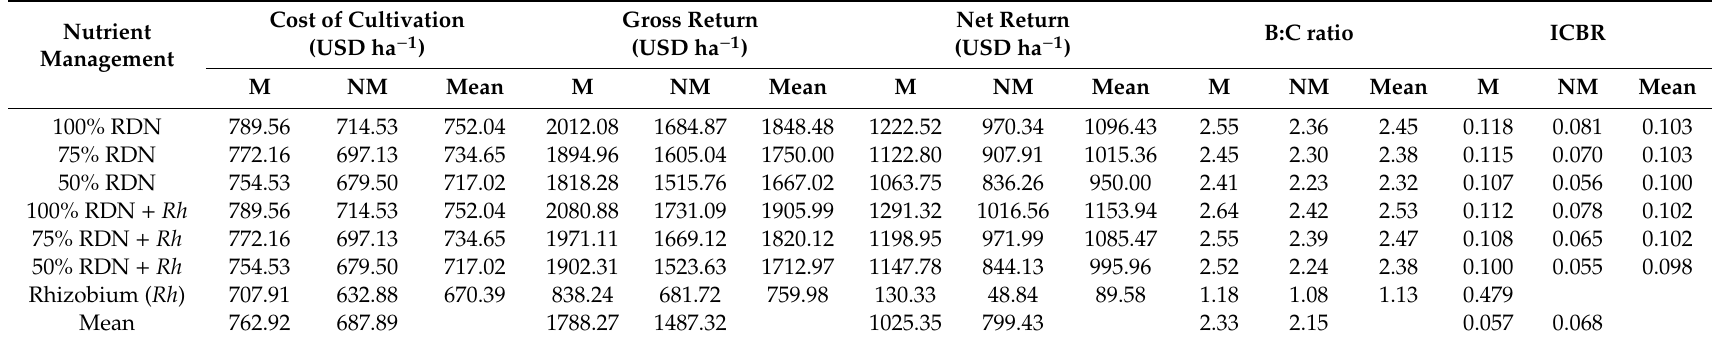
Table 10. E ff ect of soil covering and nutrient management on economics of summer peanut in